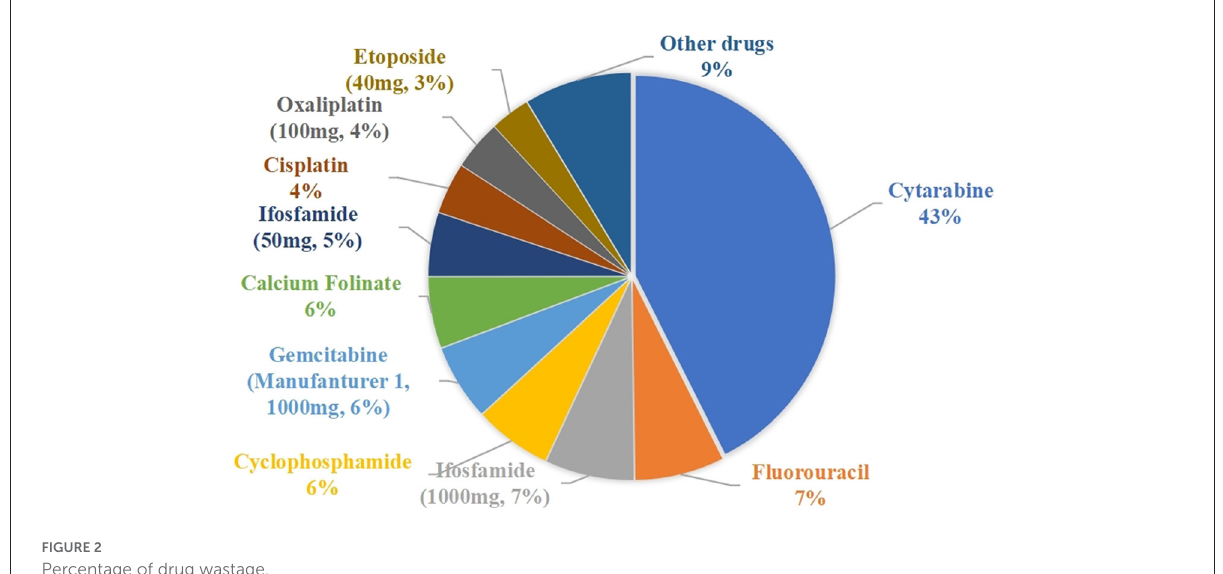
FIGURE2 Percentage of drug wastage.